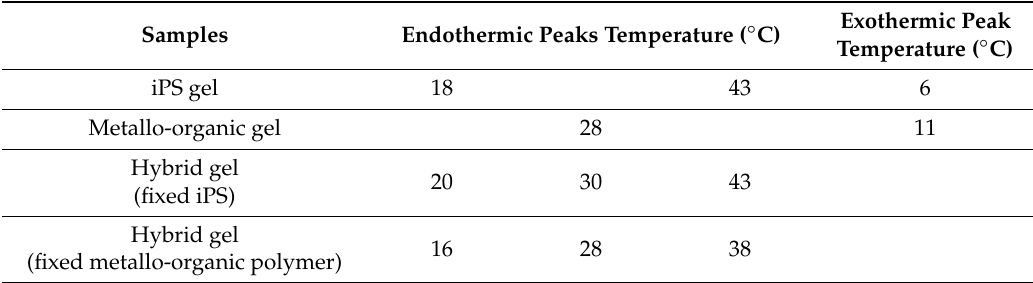
Table 1. Temperatures corresponding to endothermic and exothermic peaks of the pure iPS gel, pure metallo-organic polymer gel, and hybrid gel are collected.